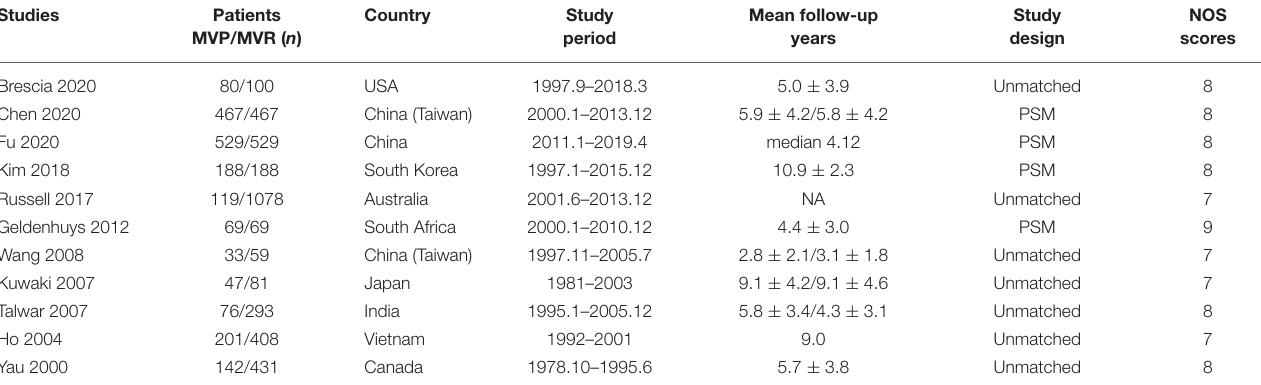
TABLE 1 | Main characteristics of the included studies. Studies Patients Country Study MVP/MVR ( n )